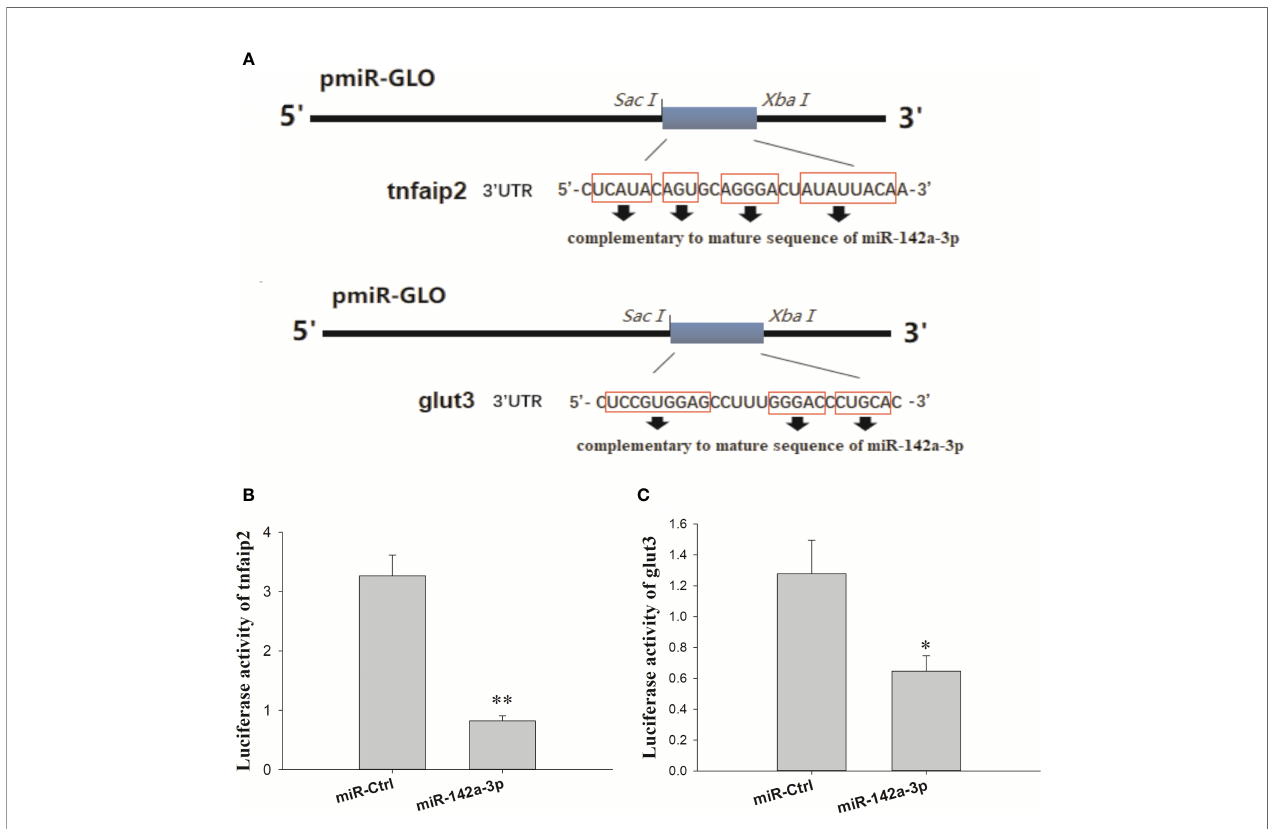
FIGURE 3 | (A) Schematic diagram of the SacI/Xbal sites. (B, C) CIK cells were transfected with miR-142a-3p agomir or control solution, along with the recombinant plasmids pmirGLO- tnfaip2 or pmirGLO- glut3 for 48 h, and the luciferase activity was determined. All values represent the mean ± SD of three independent experiments. Asterisks indicate signi fi cant differences * p < 0.05, ** p <